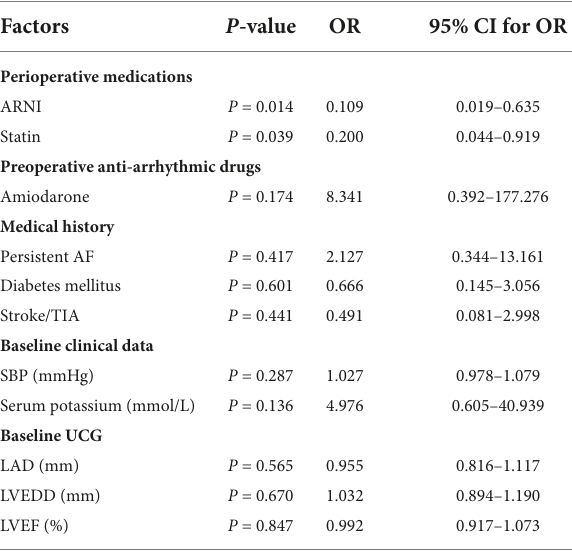
TABLE 4 Multivariate logistic regression analysis for the presence of atrial arrhythmia at 24-week follow-up. Multivariate logistic regression analysis for atrial arrhythmia